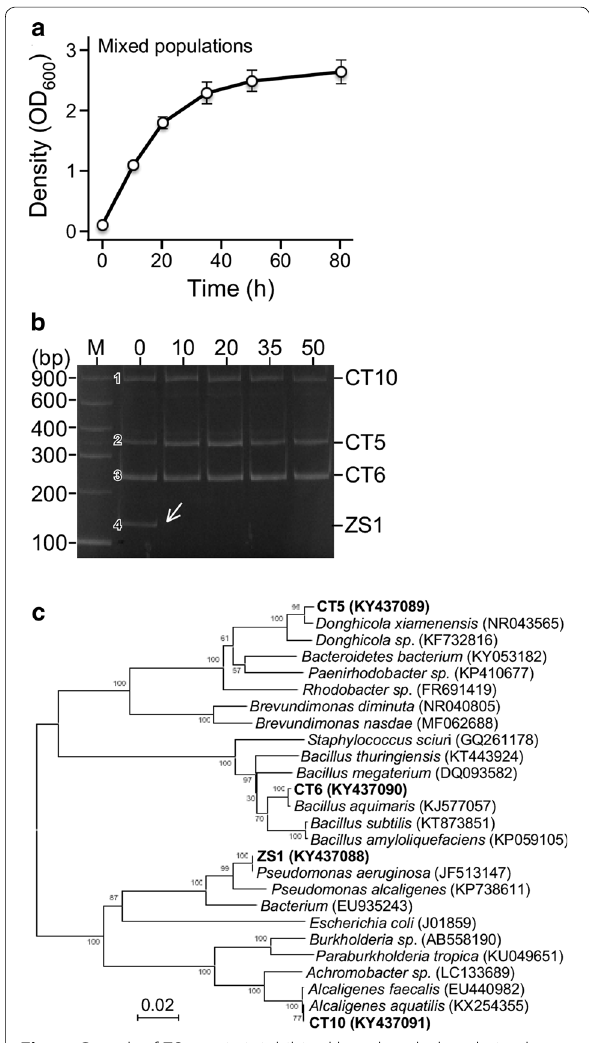
Fig. 1 Growth of ZS1 strain is inhibited by other sludge-derived microbes in MS medium supplemented with 2% YE. a Growth curve of the sludge-derived mixed culture in MS medium with 2% YE. b Dynamic change of microbial populations in mixed culture. Image of mT-RFLP analysis. Four major microbial populations in the initial culture (at 0 h) are numbered. c Phylogenetic tree analysis based on 16S rDNA sequences. The tree is built using CLUSTALW and NJPLOT. Sequence accession number of all strains is shown in